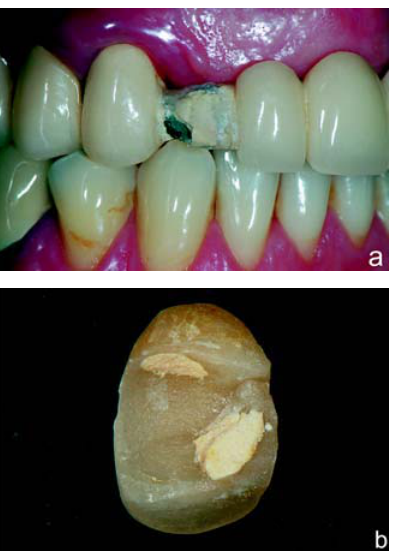
FIGURE 11- Composite resin insertion on the prosthesis (a) and ceramic fragment (b)